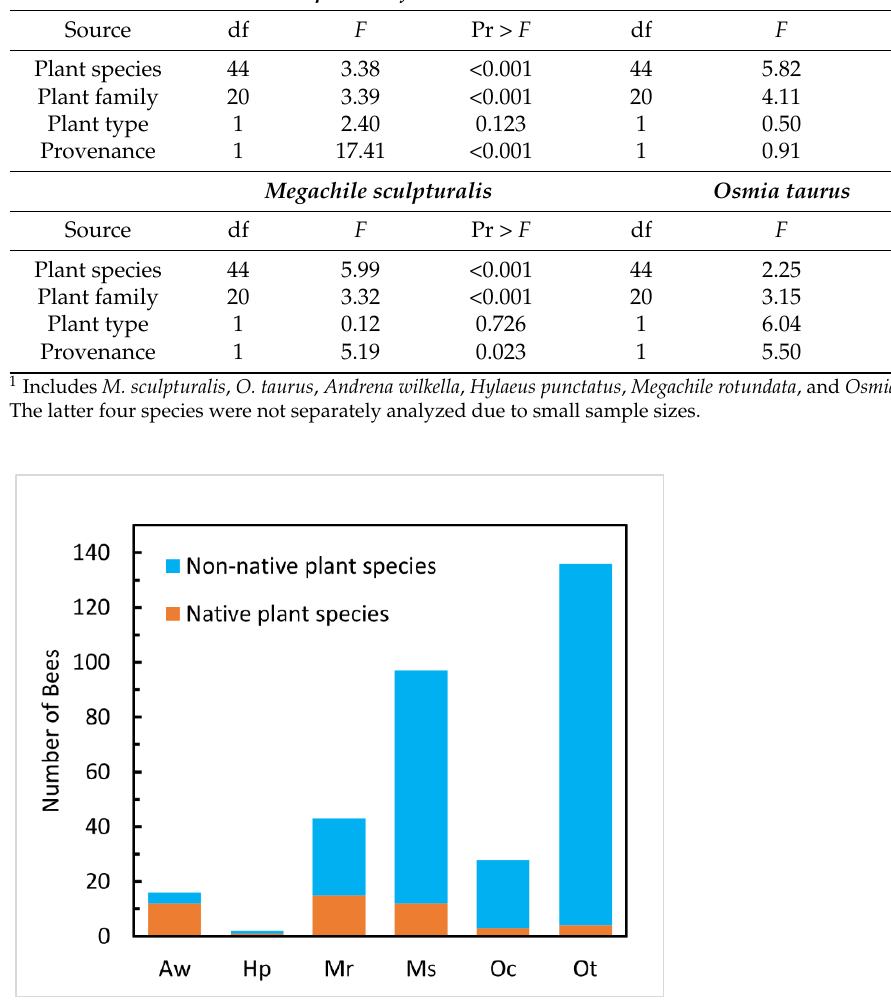
Figure 1. Total number of individuals of six non- Apis non-native bee species in ca. 50-bee samples from flowering woody landscape plants, showing proportion of each bee species collected on non- native ( n = 24) or native ( n = 21) plant species. Aw, Andrena wilkella ; Hp, Hylaeus punctatus ; Mr, Meg- achile rotundata ; Ms, Megachile sculpturalis ; Oc, Osmia cornifrons ; Ot, Osmia taurus . Those bees together accounted for 2.86% (322/11,275) of all bees sampled.